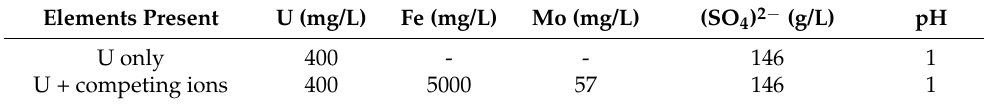
Table 2. Initial compositions of the uranium-containing simulated ore leaching solutions.